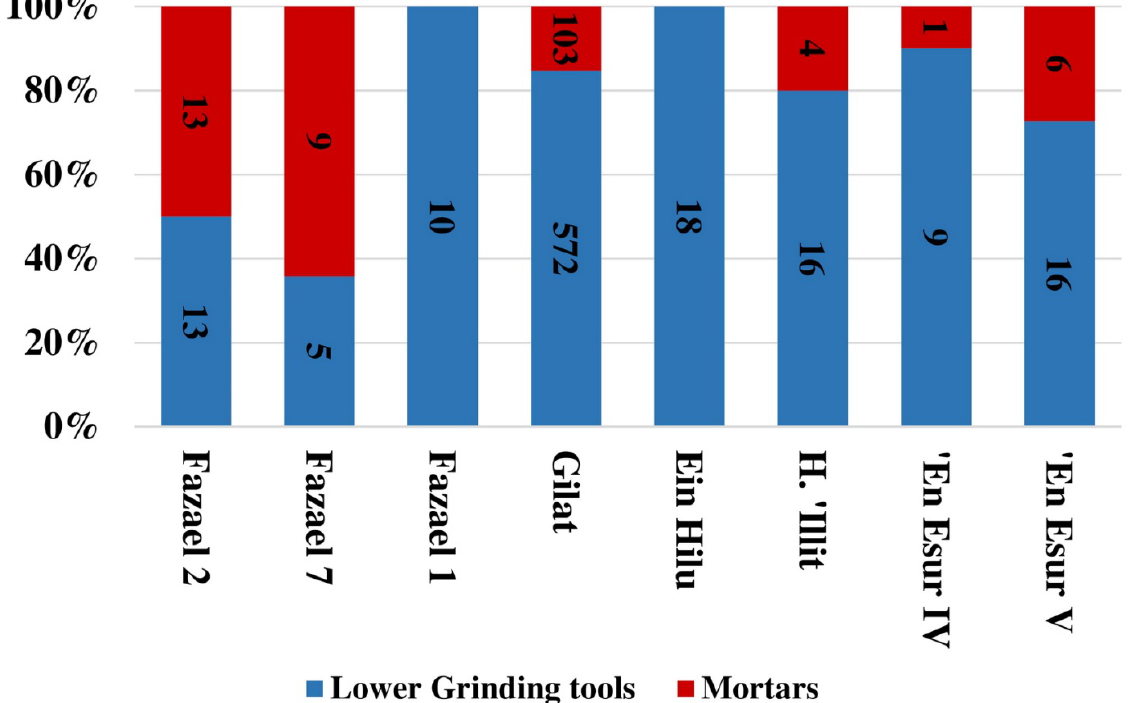
Figure 10. Frequency and quantities of lower grinding tools and mortars in Fazael 2 and Fazael 7, compared with Fazael 1 and other Late Chalcolithic sites (Rowan 2006; Rowan et al . 2006; Bar et al . 2008; Bar et al . 2014).